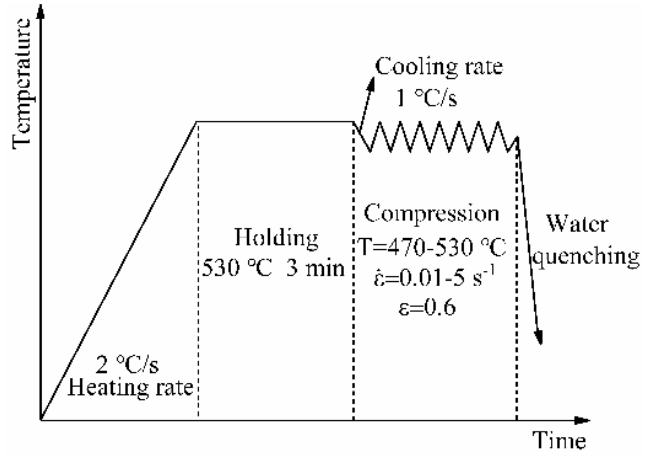
Figure 2. P rocess diagram of the thermal compression test. Figure 2. Process diagram of the thermal compression